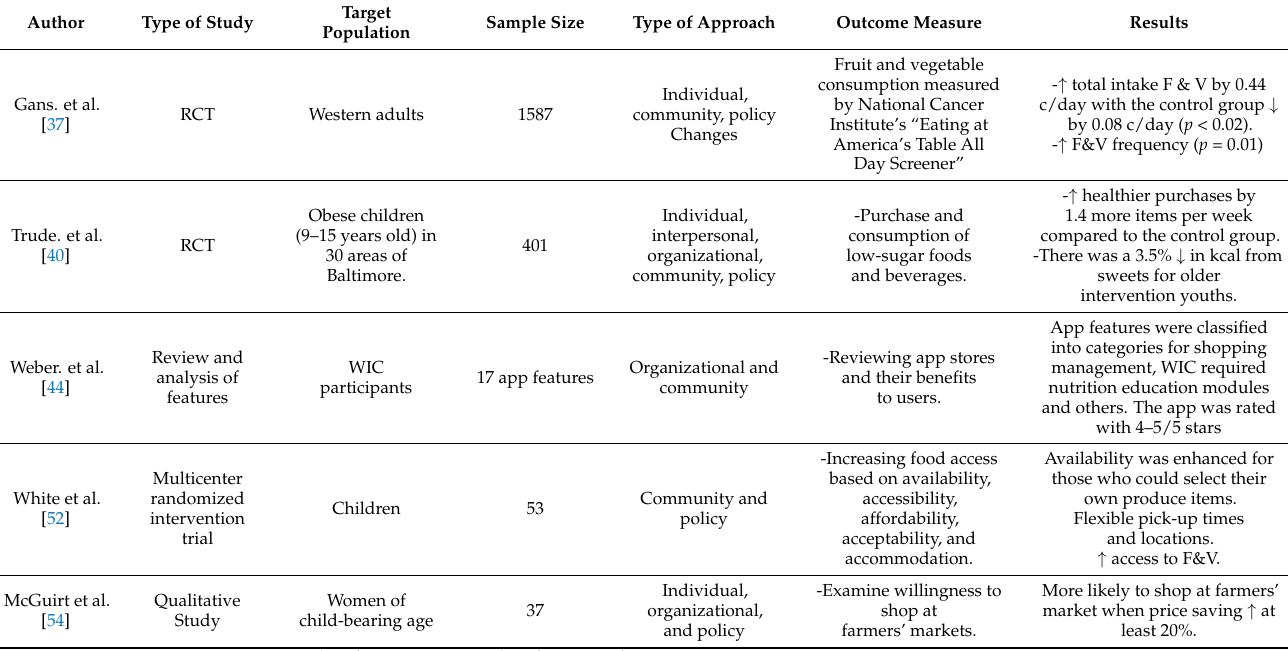
Table 2. Summary of key studies to increase access to healthy